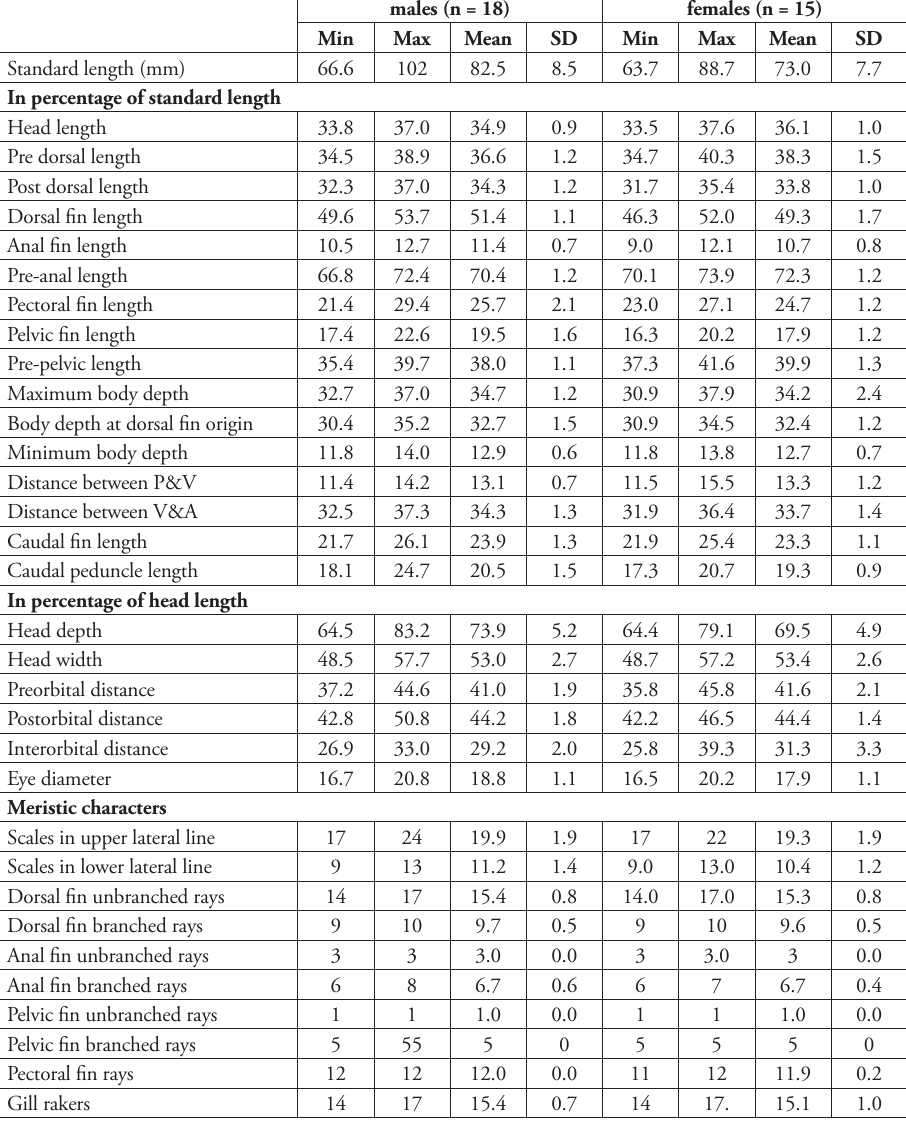
Table 1. Morphometric and meristic data of Iranocichla persa , (holotype, ZM-CBSU-IP66; paratypes, ZM-CBSU-IP59-IP65, IP67-IP78, K1120-K1127, n = 33). males (n = 18) females (n = 15)